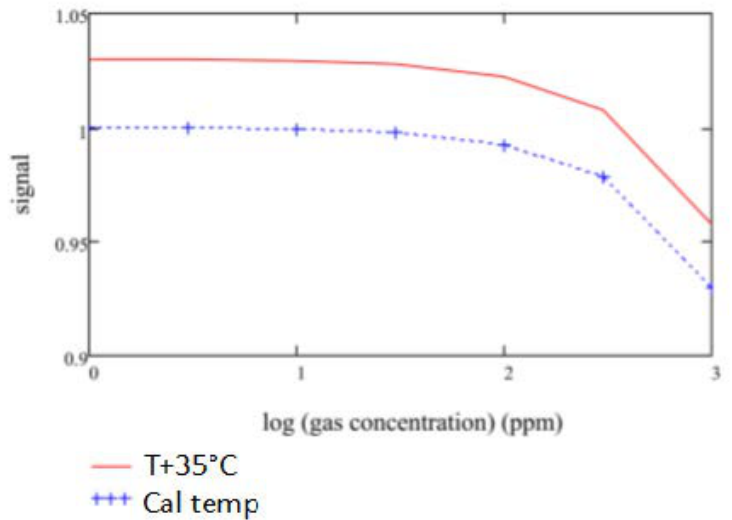
Figure 18. Design B: Detected lead selenide output with ideally designed signal and reference filters.